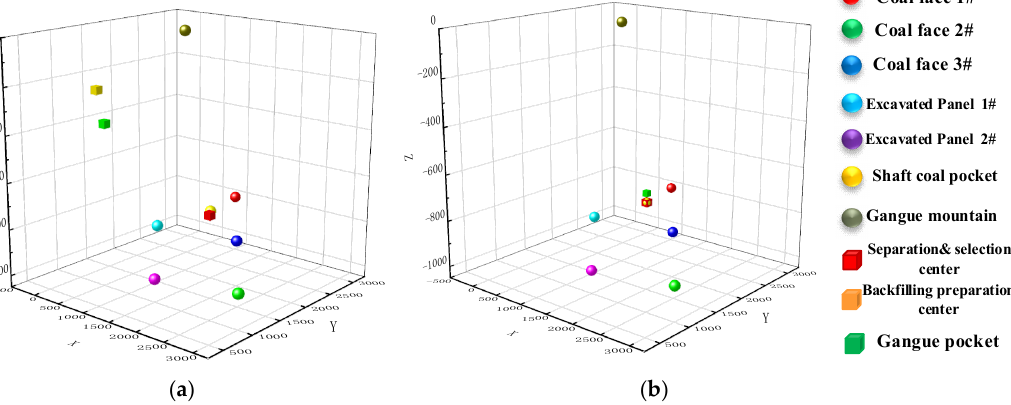
Figure 7. The spatial position relationship diagram of the logistics nodes (group 3): ( a ) PSO algorithm, ( b ) PSO–QNMs